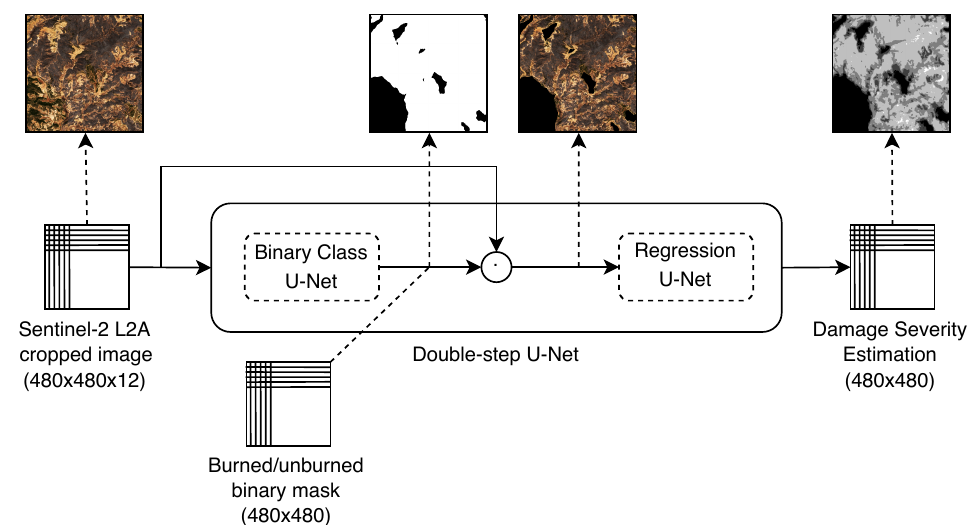
Figure 5. Double-Step U-Net simplified architecture. The damage severity estimation is computed in two steps: burned area identification through the Binary Class U-Net and damage severity estimation by means of Regression U-Net. The Regression U-Net receives as input the Sentinel-2 L2A image filtered with the binary segmentation